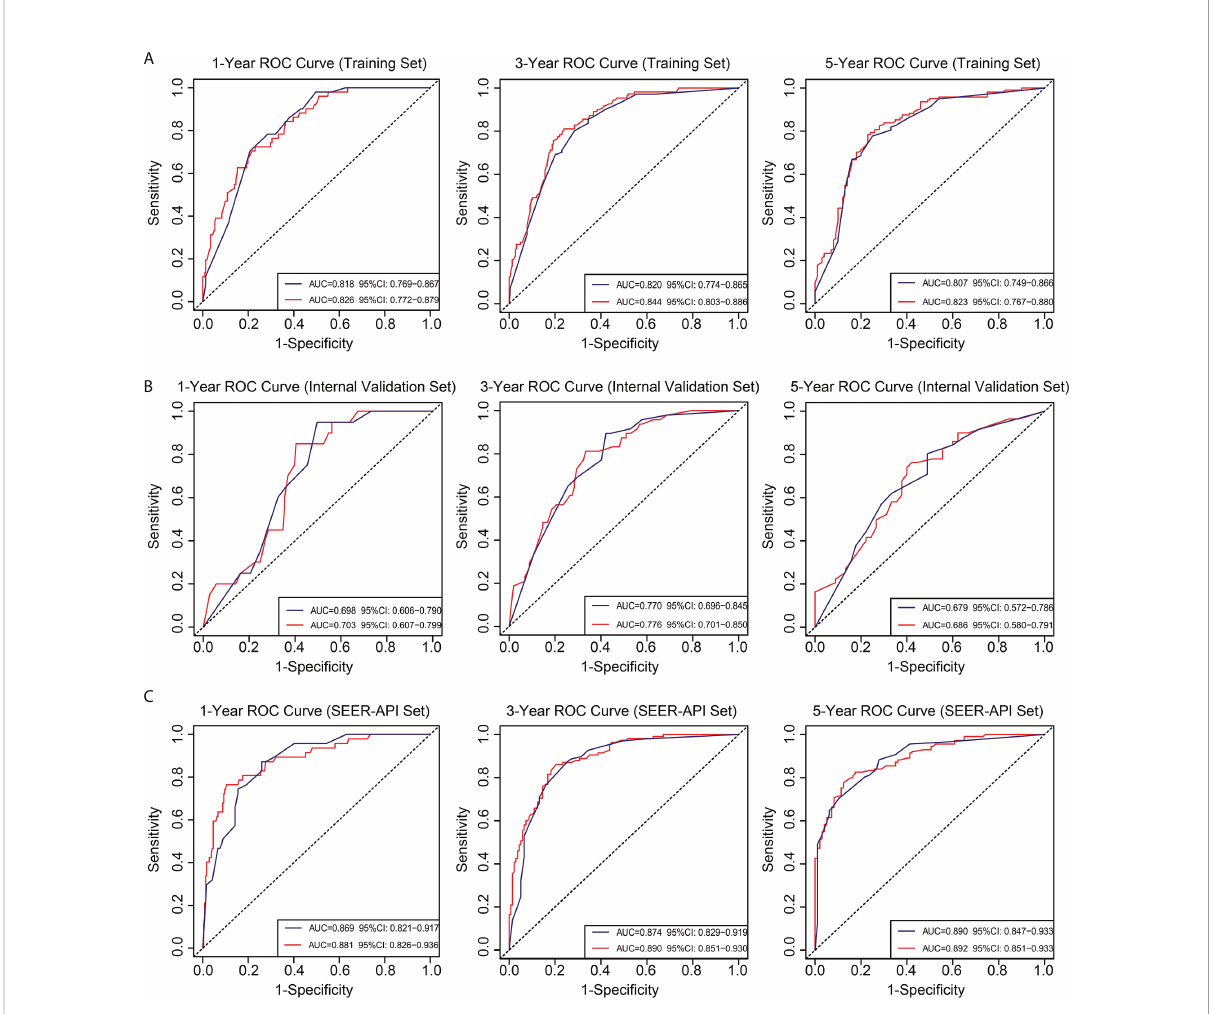
FIGURE 4 Receiver operating characteristic (ROC) curves for the two nomograms. Based on 1-, 3-, and 5-year CSS, the ROC curves for the nomograms were plotted in the training set (A) , internal validation set (B) , and SEER-API external validation set (C) , respectively. The blue line represents model 1, and the red line represents model